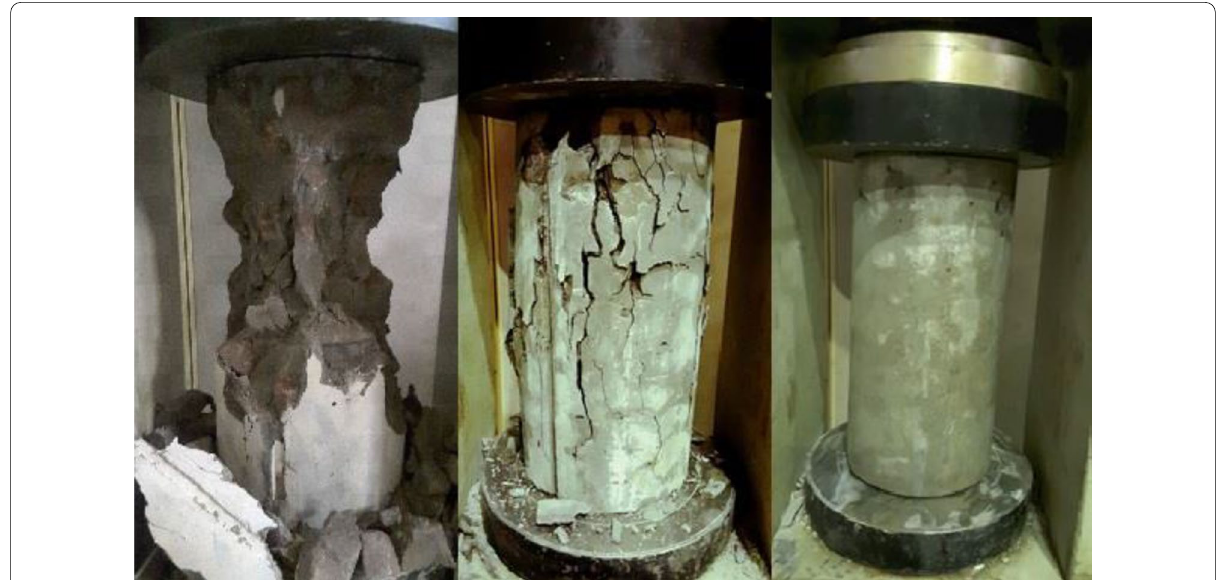
Fig. 12 PAC cylindrical specimens under uniaxial compressive load: (Right) cylindrical specimen, (Middle) crack growth during loading, (Left) failure.